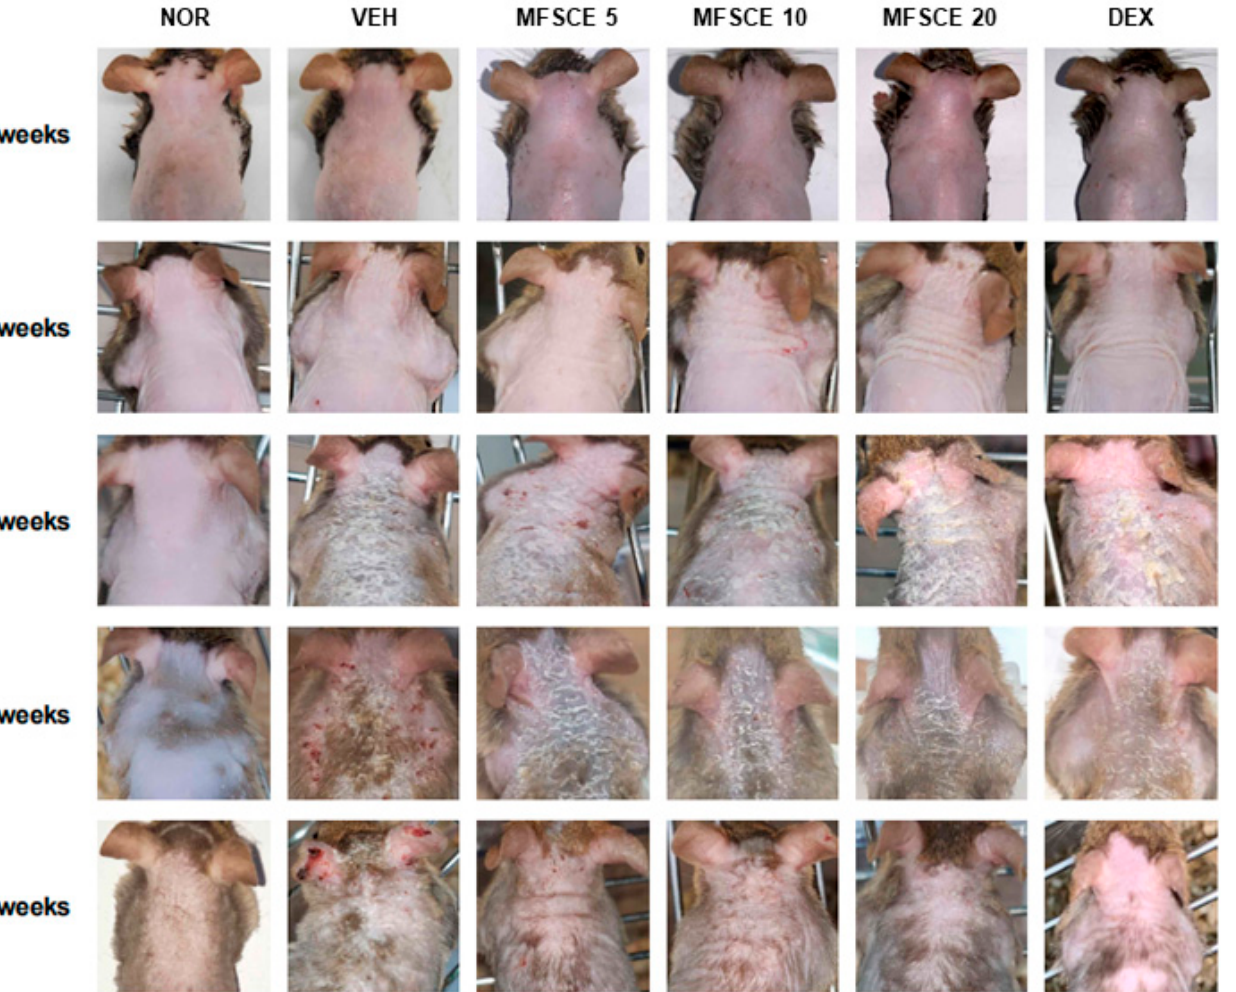
Figure 2. Clinical pictures of AD-like dorsal skin lesions in HDM-sensitized NC/Nga mice. Six groups: NOR group, VEH group (HDM treatment), MFSCE 5 group (HDM treatment + MFSCE 5 uL/head), MFSCE 10 group (HDM treatment + MFSCE 10 uL/head), MFSCE 20 group (HDM treat- ment + MFSCE 20 uL/head), and DEX group (HDM treatment + DEX 540 ug/head).